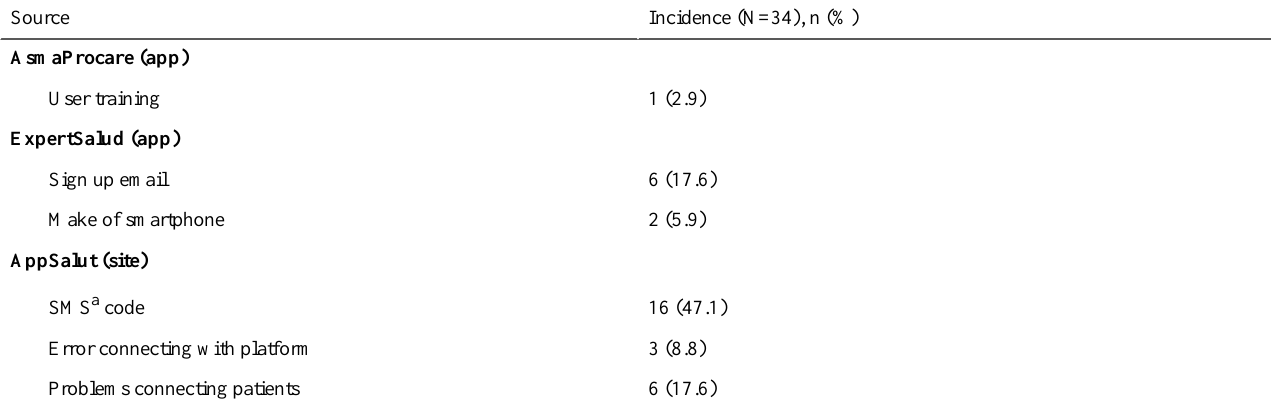
Table 5. Incidences by